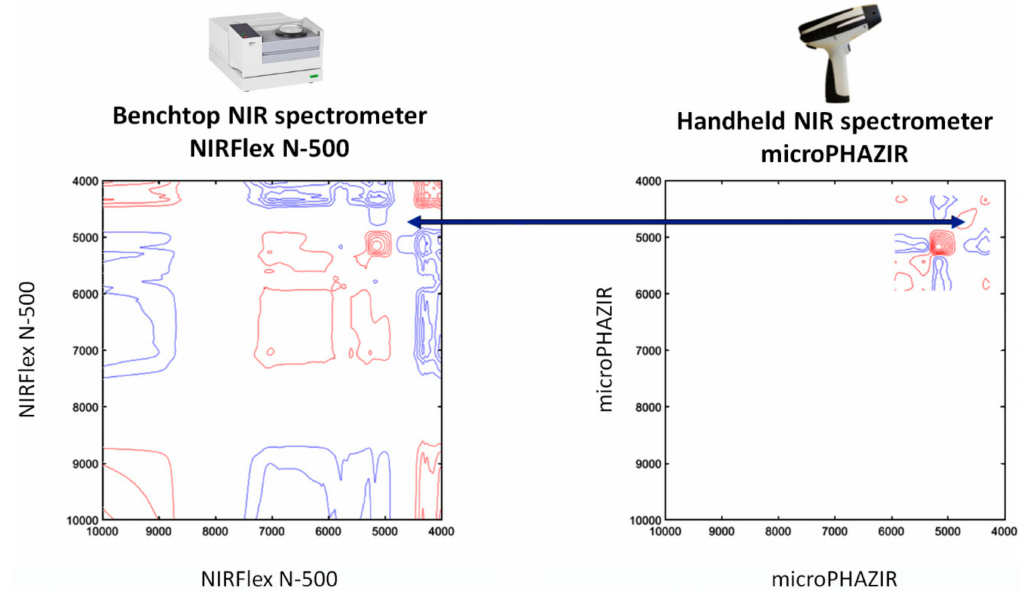
Figure 7. A visual assessment and evaluation of the chemical sensitivity profiles of NIR spectrometers (reference benchtop vs. handheld) by two-dimensional correlation spectroscopy